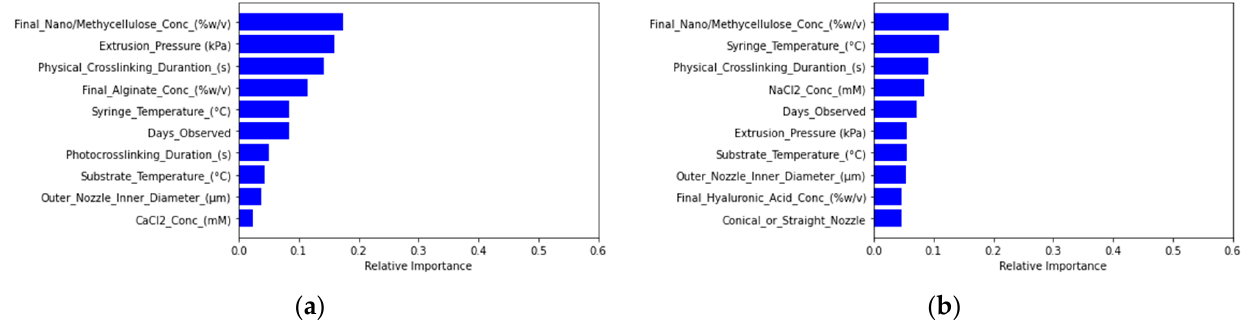
Figure 3. Feature importance rankings of the material, equipment, and experimental parameters based on ( a ) random forest regression and ( b ) random forest classification modeling of cell viability.